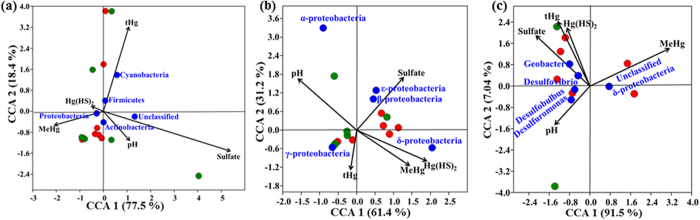
Canonical correspondence analysis plots.First two axes of CCA1 and CCA2 represent the relationships between environmental variables and bacterial diversity at (a) phylum level, (b) class level for Proteobacteria taxonomic class, (c) genus level (mercury methylating Deltaproteobacteria groups). Symbols indicate phyla/classes/genus (blue dots), high MeHg samples (red dots), low MeHg samples (green dots) and environmental variables (black arrows). Arrows indicate the direction and magnitude of measurable variables associated with bacterial community structures. The percentage of variation explained by each axis is shown in axis label.